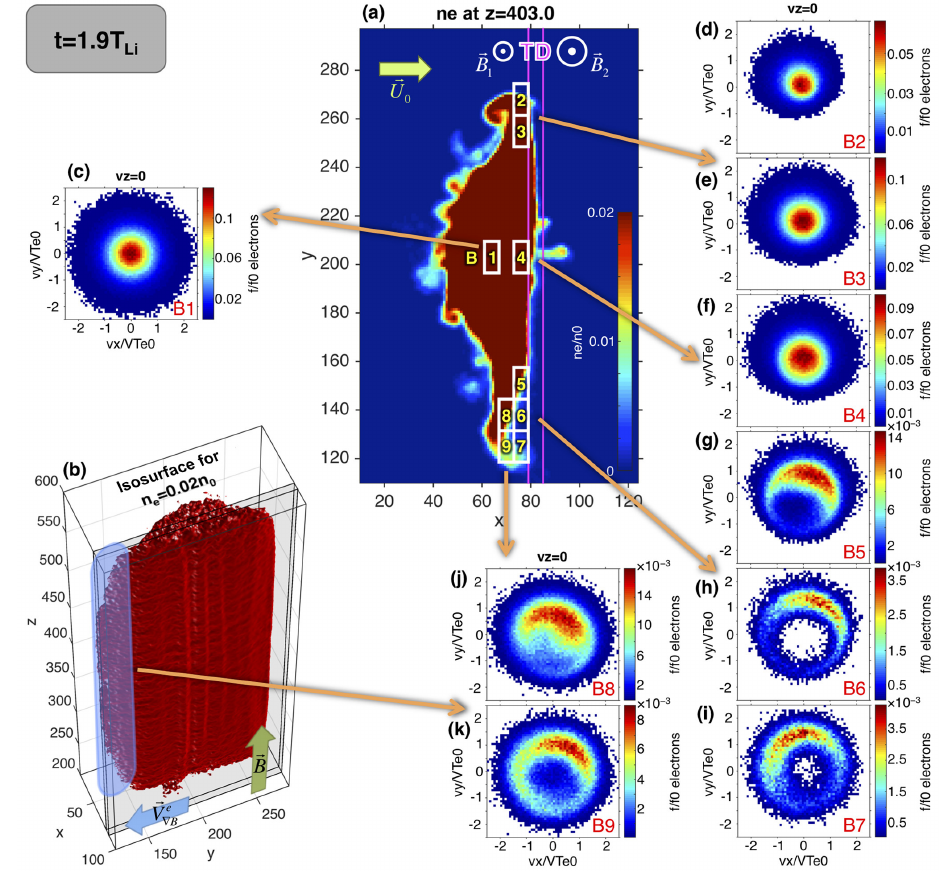
Figure 3. Snapshot of 3-D PIC simulation at t = 1 . 9 T Li (phase B). (a) Electron number density in the xOy plane for z = 403. (b) The 3- D density isosurface for n e = 0 . 02 n 0 . (c–k) Electron VDFs in the space of perpendicular velocities for the spatial bins shown with white rectangles in panel (a) . The two magenta lines mark the TD’s